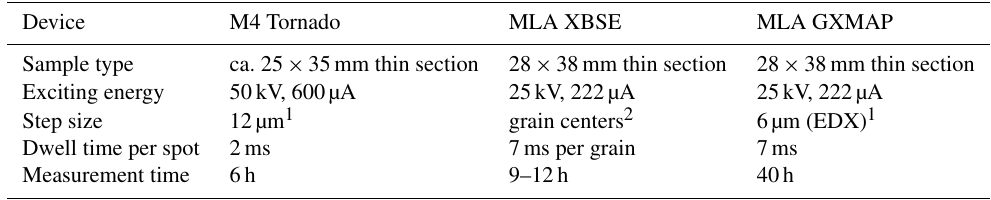
Table 1. Details of the M4 Tornado mapping and SEM + MLA measurement. Device